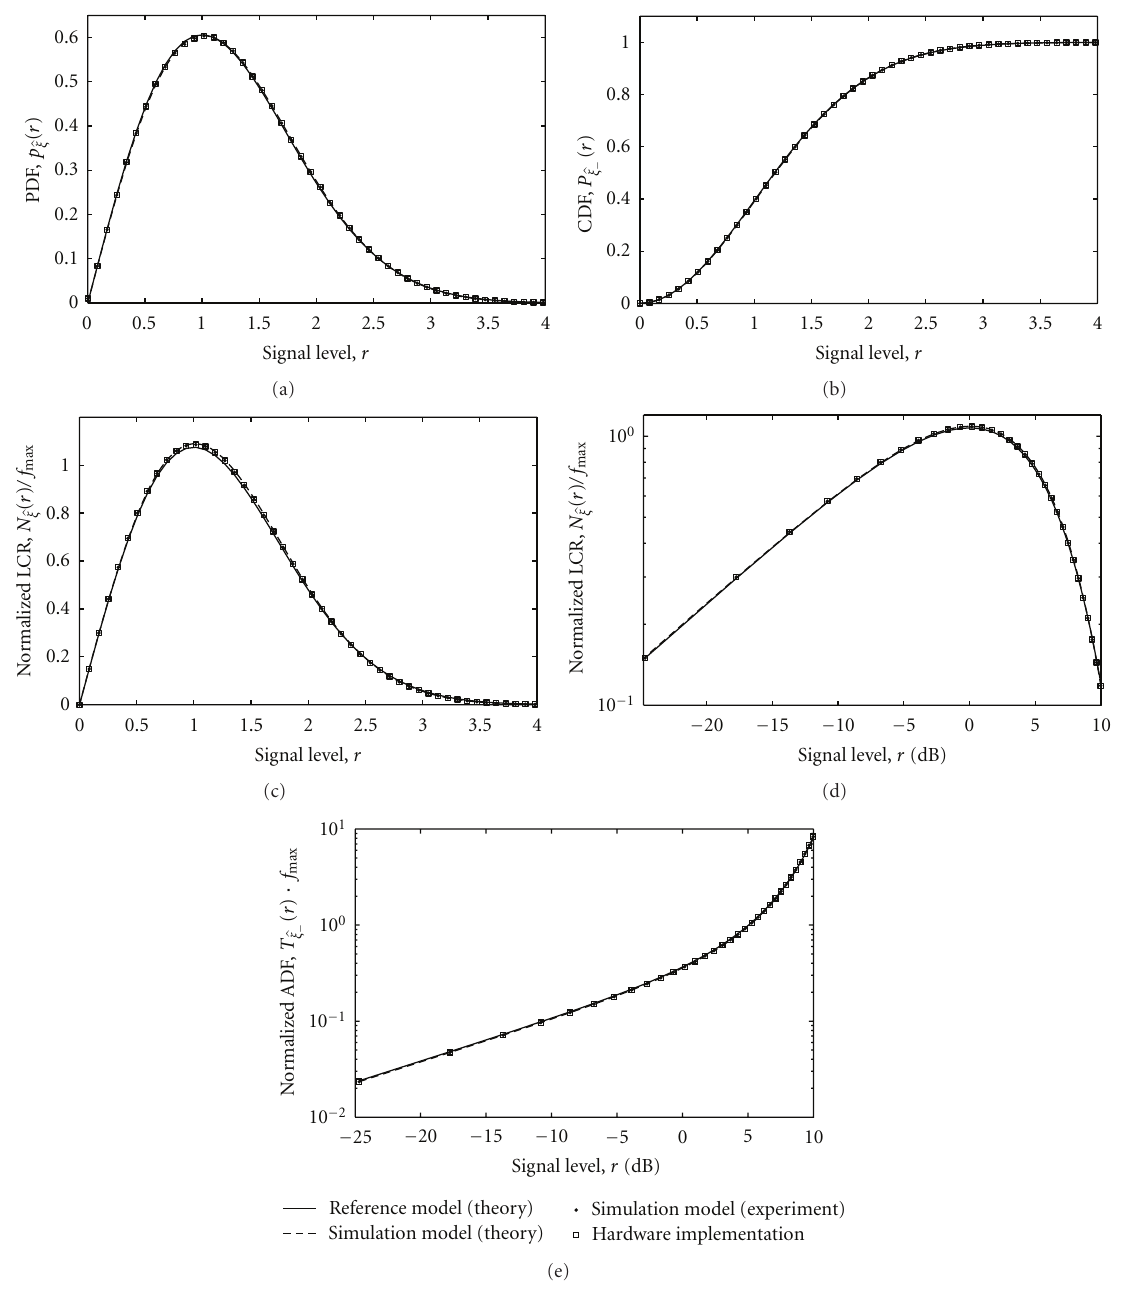
Figure 5: PDF, CDF, LCR, and ADF comparison results of the generated envelope process under isotropic scattering (Jakes PSD) using σ 2 0 = 1, N = 32, and f max =